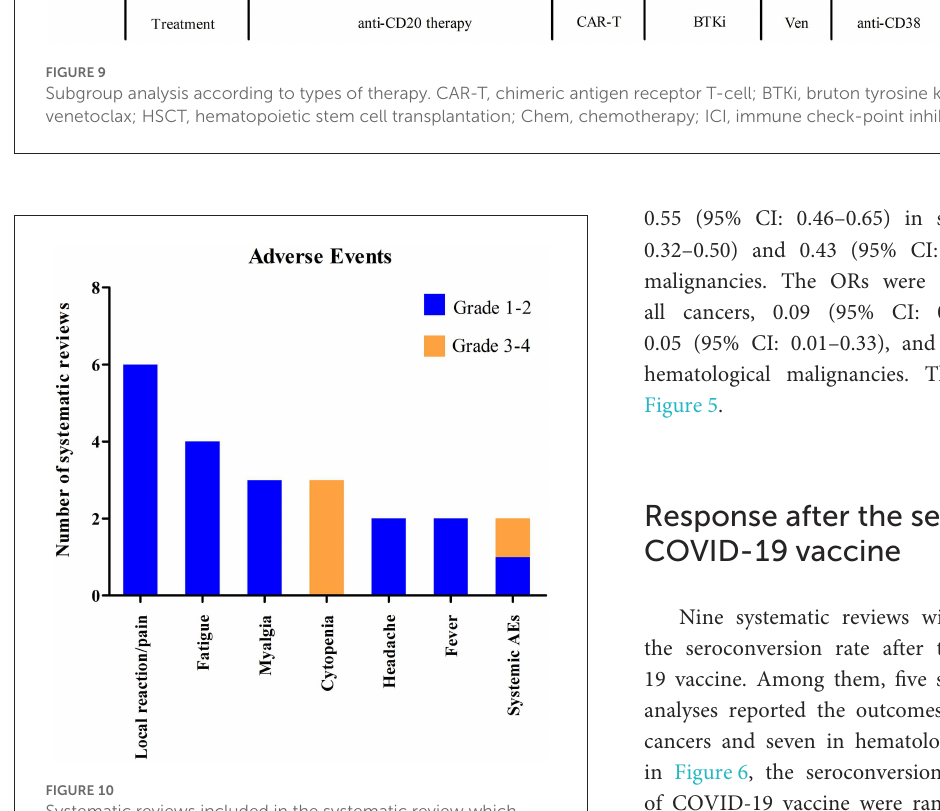
Response after the second dose of COVID-19 vaccine Nine systematic reviews with meta-analyses focused on the seroconversion rate after the second dose of COVID- 19 vaccine. Among them, five systematic reviews with meta- analyses reported the outcomes in all cancers, four in solid cancers and seven in hematological malignancies. As shown in Figure 6, the seroconversion rates after the second dose of COVID-19 vaccine were ranged from 65.30 to 87.70% in all cancers, 91.60 to 96.00% in solid cancers, and 58.00% to 72.60% in hematological malignancies. Two systematic reviews without meta-analyses also reported the data after second dose of COVID-19 vaccine. The systematic review by Corti et al. (19) reported that the seroconversion rate ranged from 7.30 to 100.00% in all cancers, from 47.50 to 100.00% for solid cancers and from 7.30 to 88.80% for hematological malignancies. The seroconversion rates among all cancers, solid cancers and hematological malignancies in the systematic review by Galmiche et al. (21) were ranged from 39.00 to 98.00%, 64.00 to 98.00%, and 39.00 to 86.00%,